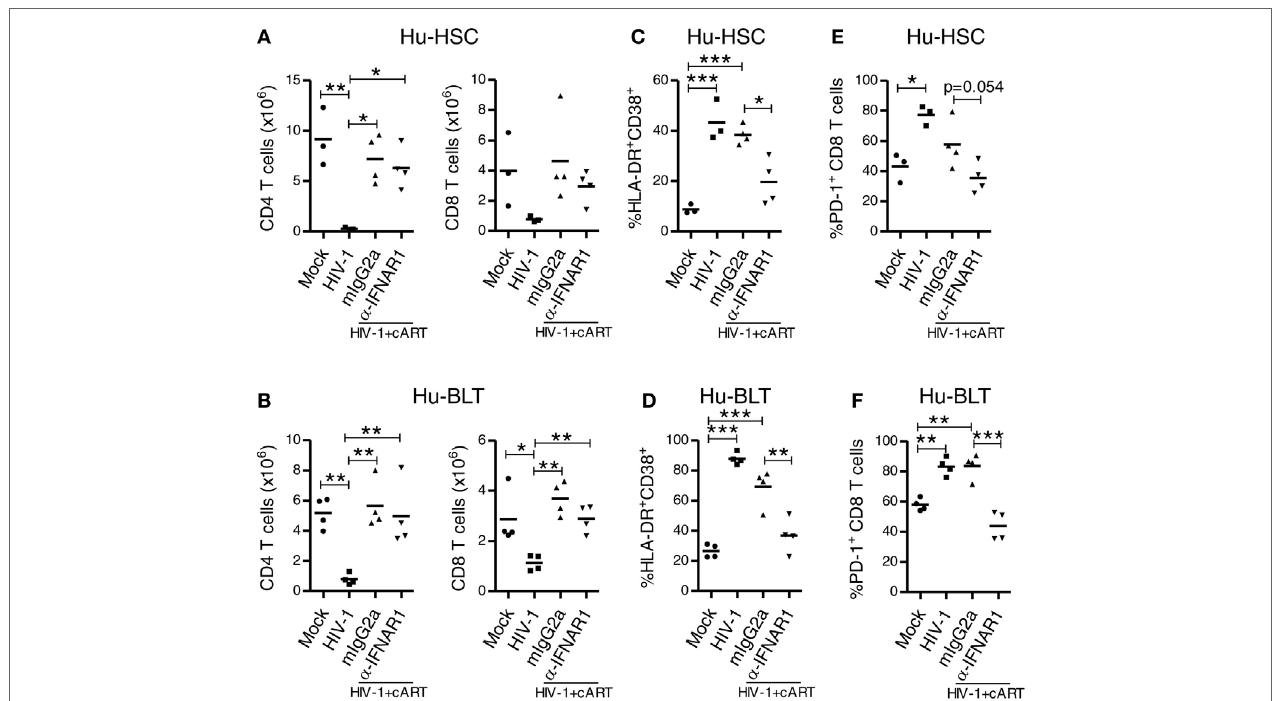
FigUre 8 | IFNAR blockade reduces activation and PD-1 expression on CD8 T cells in both HIV-1 infected NRG-hu HSC and NRG-hu Thy/HSC mice under combined antiretroviral therapy (cART). NRG-hu HSC and NRG-hu Thy/HSC mice infected with HIV-1 were treated with cART from 4 to 12 weeks postinfection (wpi). From 7 to 10 wpi, the cART-treated mice were injected with α -IFNAR1 antibody or isotype control mIgG2a antibody. Mice were sacrificed at 12 wpi. (a,B) Summarized data show numbers of human CD4 and CD8 T cells from spleens of NRG-hu HSC (a) and NRG-hu Thy/HSC (B) mice. (c,D) Summarized data show percent HLA-DR + CD38 + of CD8 T cells from spleens of NRG-hu HSC (c) and NRG-hu Thy/HSC (D) mice. (e,F) Summarized data show percent PD-1 + of CD8 T cells from spleens of NRG-hu HSC (e) and NRG-hu Thy/HSC (F) mice. Shown are representative data from n = 3 (NRG-hu HSC/Mock), n = 3 (NRG-hu HSC/HIV-1), n = 4 (NRG-hu HSC/HIV-1/cART/mIgG2a), n = 4 (NRG-hu HSC/HIV-1/cART/ α -IFNAR1), n = 4 (NRG-hu Thy/HSC/Mock), n = 4 (NRG-hu Thy/HSC/ HIV-1), and n = 4 (NRG-hu Thy/HSC/HIV-1/cART/mIgG2a), n = 4 (NRG-hu Thy/HSC/HIV-1/cART/ α -IFNAR1) mice. Each dot represents one individual mouse; bars indicate mean (* P < 0.05, ** P < 0.01, and *** P < 0.001, by one-way analysis of variance and Bonferroni’s post hoc